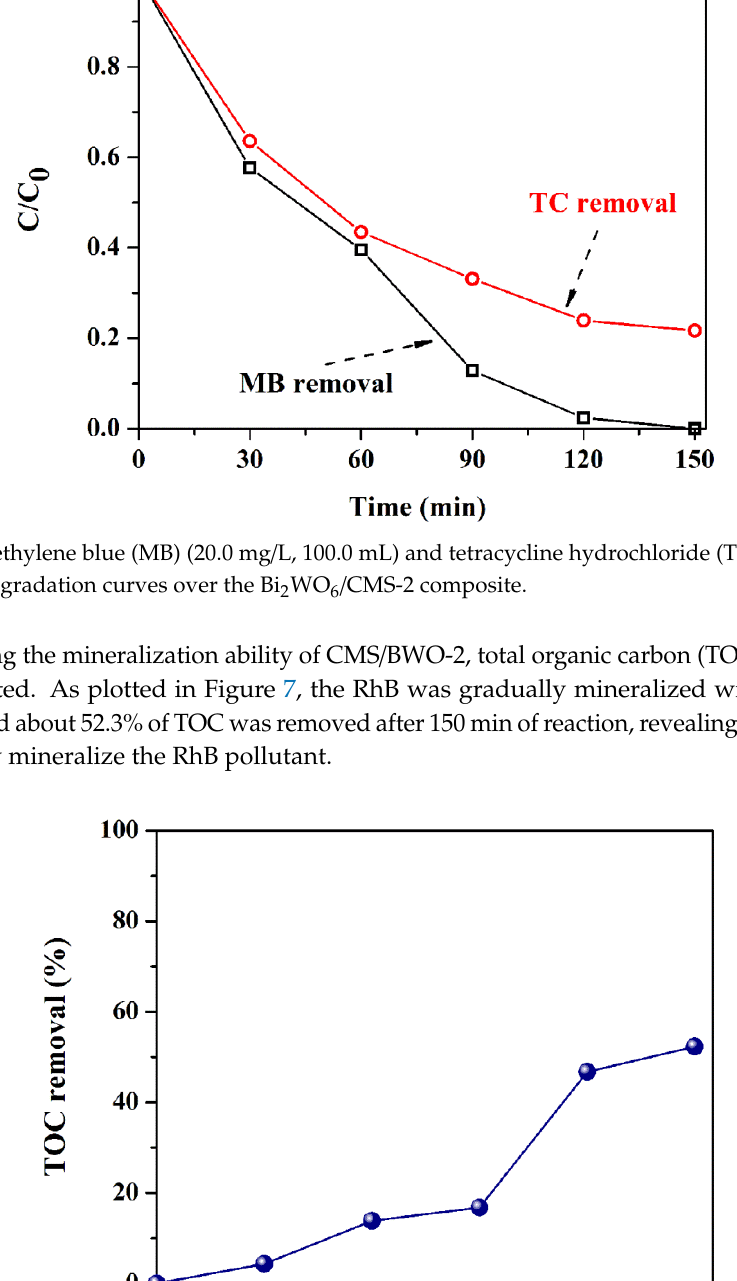
Figure 8. ( a ) Five recycling runs of CMS/BWO-2 for RhB removal; ( b ) the XRD patterns of the original and recycled CMS/BWO-2.